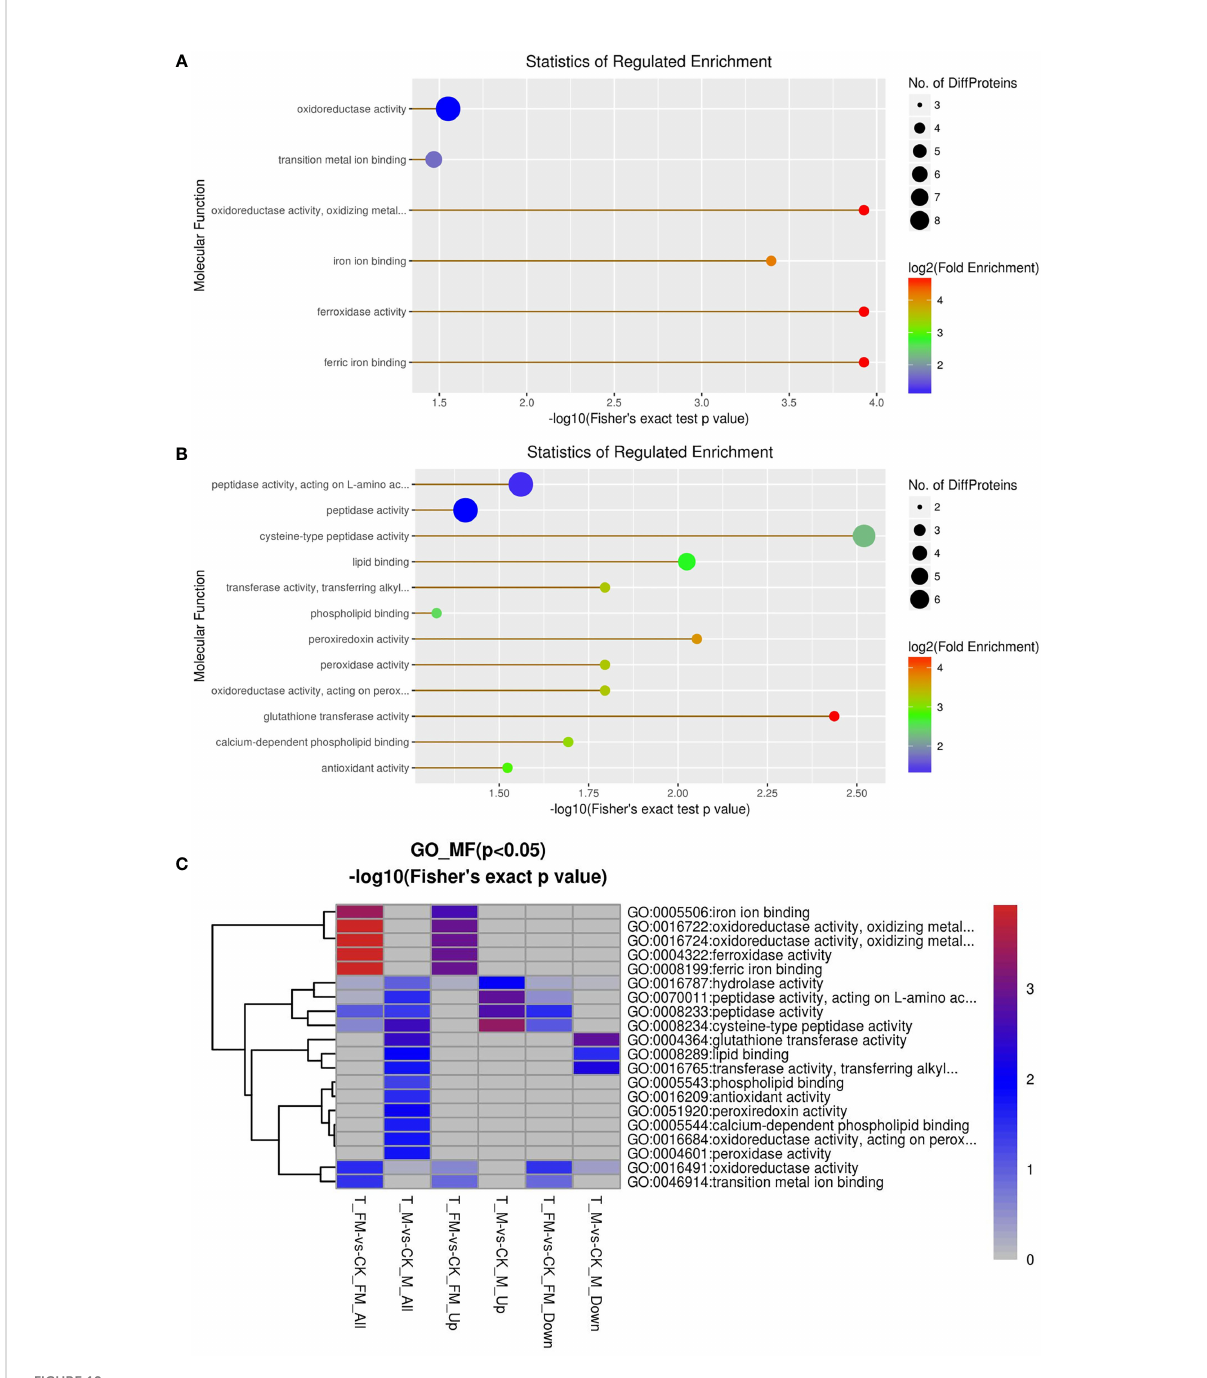
FIGURE 10 GO enrichment analysis for molecular function in female (A) and male (B) adult S. japonicum